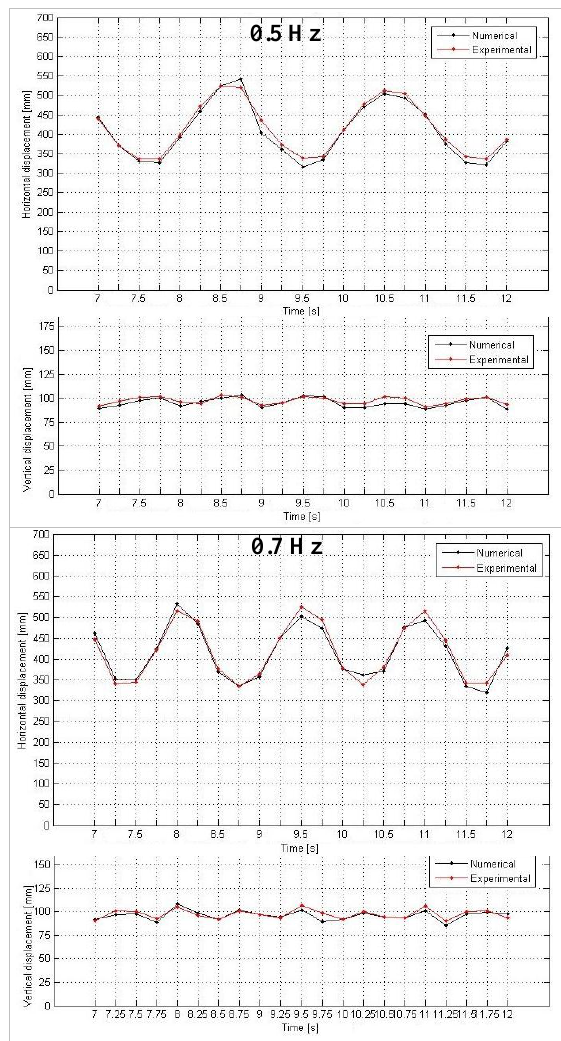
Figure 17. Comparison between numerical and experimental data in the time interval [7 ÷ 12] s: horizontal displacements and vertical displacements.